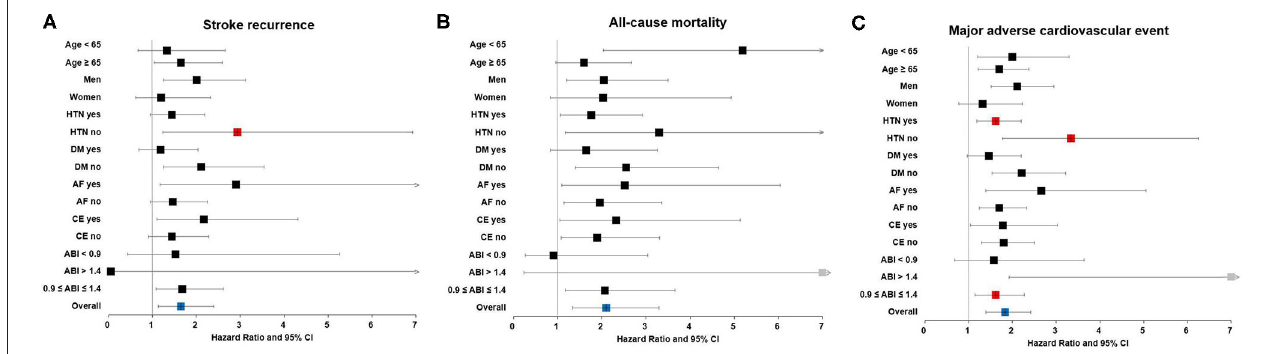
FIGURE 3 | Sensitivity analysis. Association between low TBI and long-term outcomes, including (A) stroke recurrence, (B) all-cause mortality, and (C) major adverse cardiovascular events in patients with acute ischemic stroke. Red square boxes indicate p < 0.05 for both interaction and subgroup analysis in multivariable Cox proportional hazards regression. ABI, ankle-brachial index; AF, atrial fibrillation; CE, cardioembolism; CI, confidence interval; DM, diabetes mellitus; HTN, hypertension; TBI, toe-brachial index.